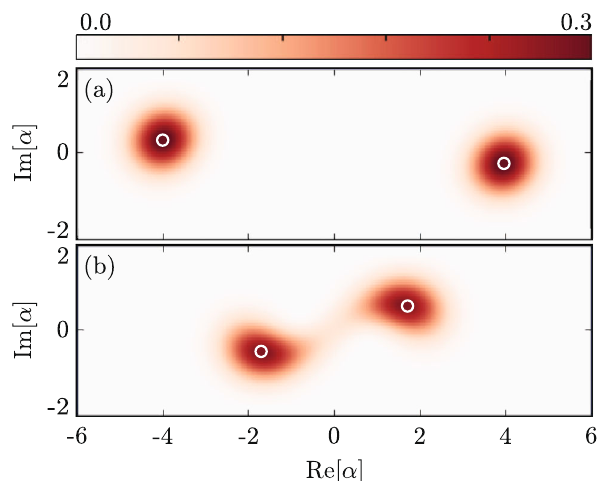
Fig. 1 Steady-state Wigner function of a two-photon driven KNR with | K | / κ = 1/8 and a E p = 16 K , K > 0 and b E p = 4 K , K < 0, 1 = 16 and ~1/4, respectively. The white corresponding to κ = 8 j K α 2 0 j (cid:5) circles indicate the expected position of the coherent